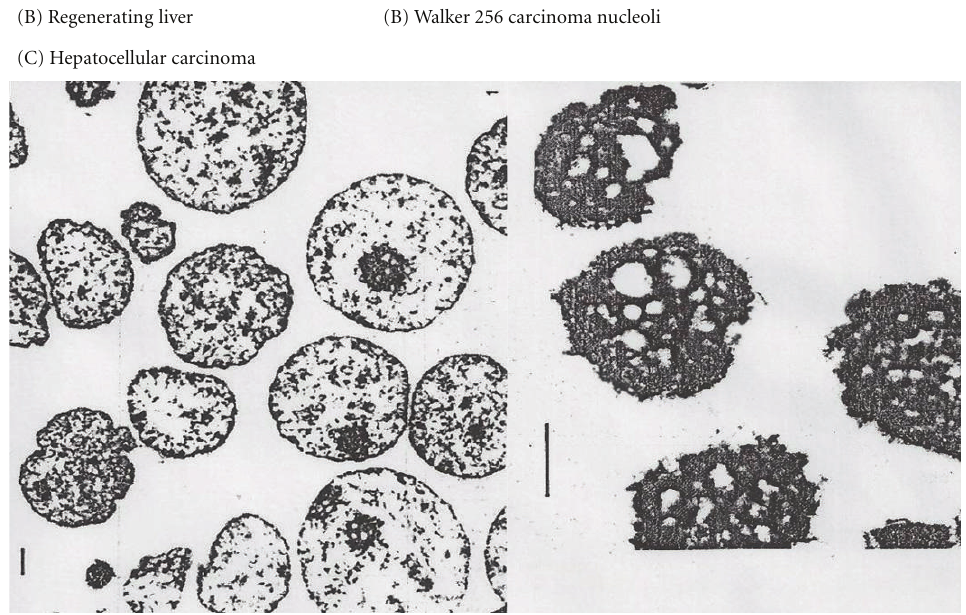
Figure 1: Nuclear and nucleolar morphology. Normal rat liver nuclei have 1–6 round nucleoli which are less than 2 μ m in diameter. In regenerating liver, cells contain enlarged nucleoli. In tumor cells (hepatocellular carcinoma), the nucleoli are not only enlarged but also they become pleomorphic in morphology. Nuclei were isolated by homogenization in 2.3–2.4 M sucrose containing 3.3 mM CaCl 2 . Nuclei were sonicated in 0.34 M sucrose and layered on 0.88 M sucrose for purification by centrifugation. Isolated nuclei and nucleoli had high purity, and morphologies were well preserved